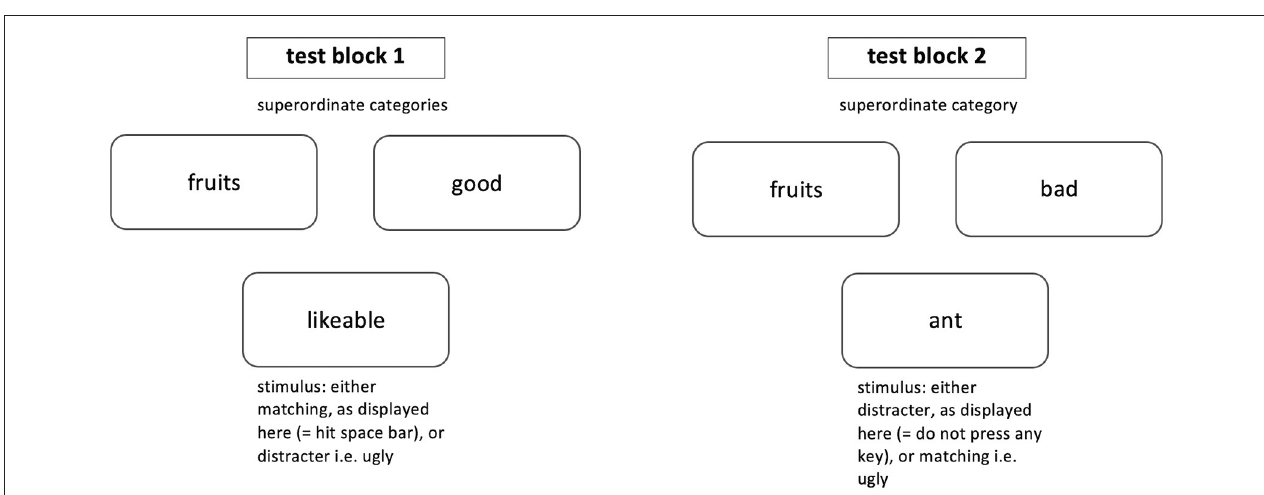
at the same time and are displayed in Figure 4 .